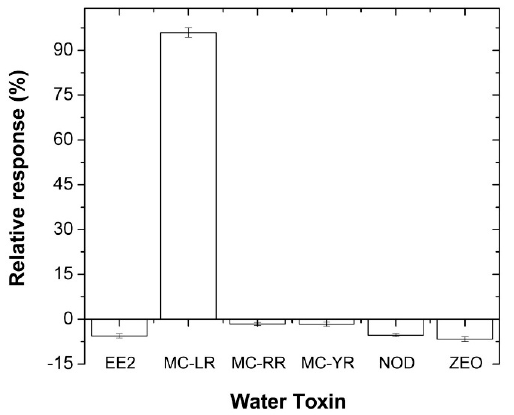
Figure 7. Relative CV responses used to evaluate cross-reactivity between freshwater toxins. EE2 = 17 β -estradiol; NOD = Nodularin-R; ZEO = zearalenone.